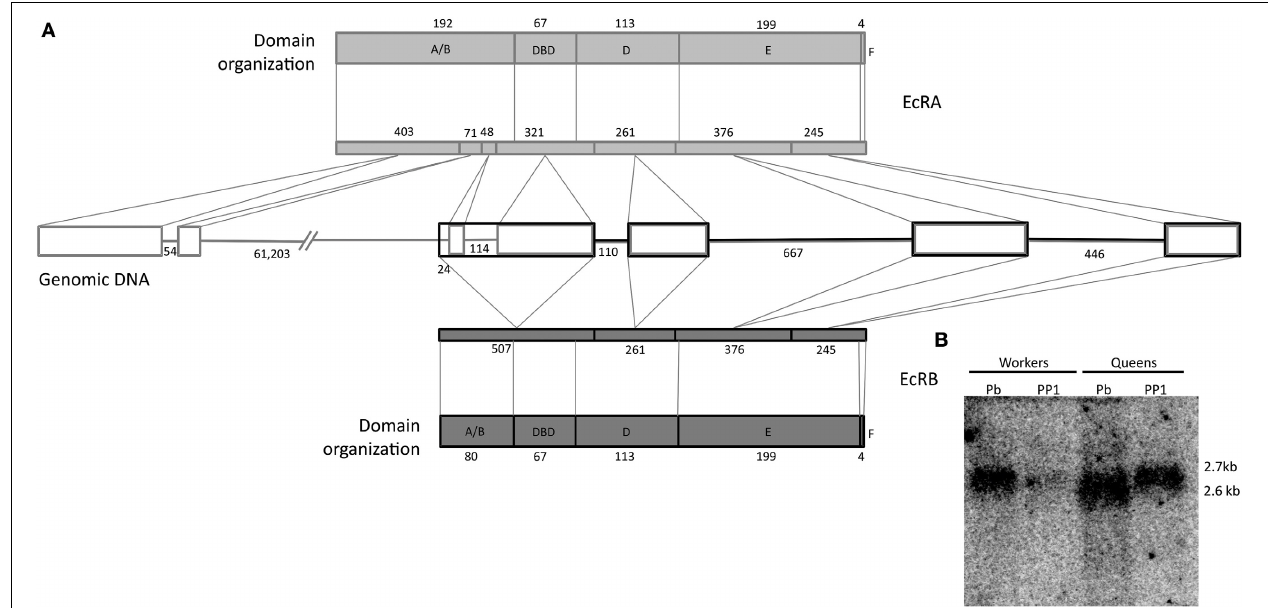
FIGURE 1 | Gene and protein organization of honeybee EcR. (A) Genome: rectangles represent exons, and lines are introns, both are indicated with their respective numbers of nucleotides. Protein domains: Shown are the five domains with their respective amino acid numbers. The lenght of the coding sequence of each exon within the respective EcR domain is marked by